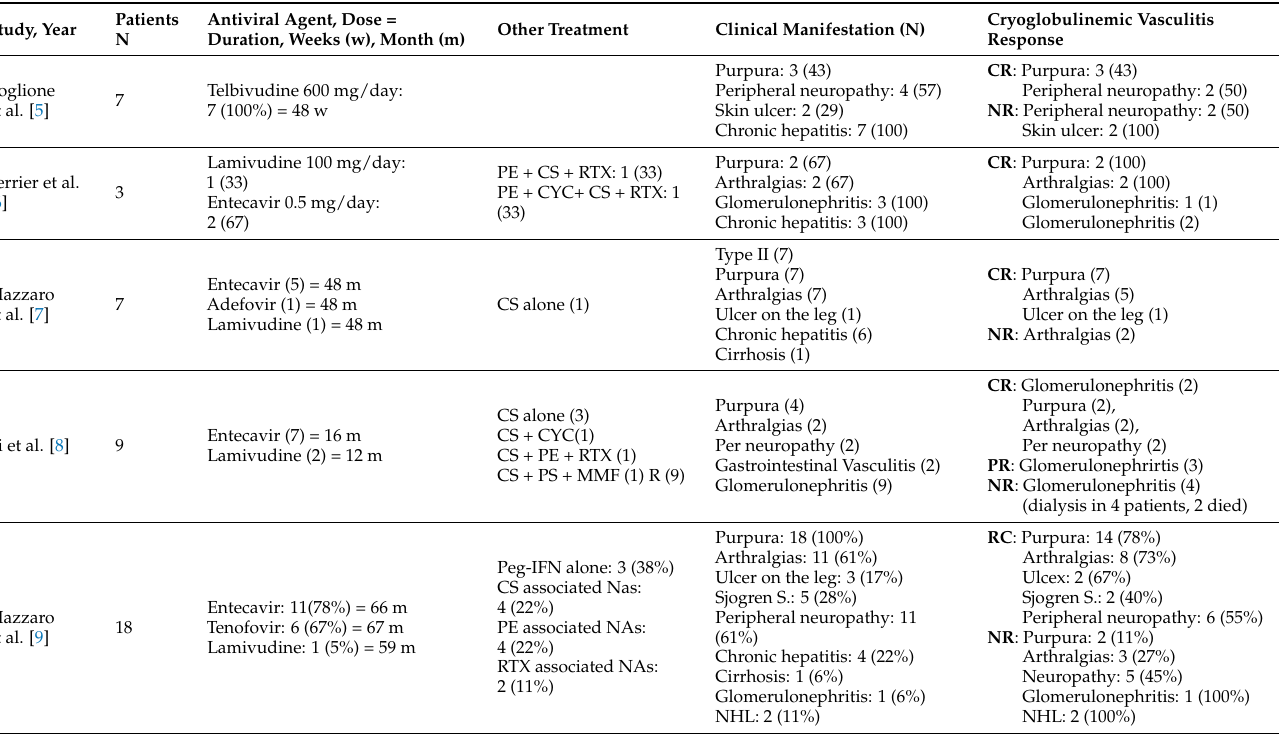
Table 2. Nucleotide anologues (NAs) therapy in patients with HBV-related cryoglobulinemic